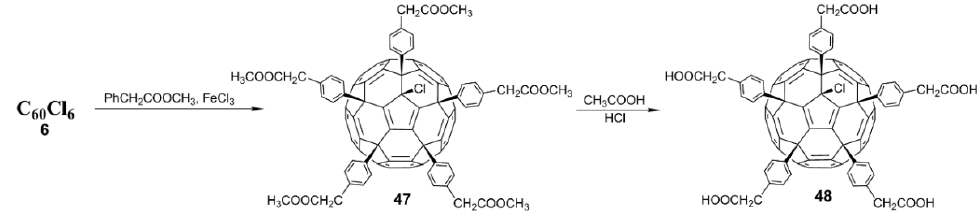
Figure 13. Schematic diagram of synthetic route of carboxylic fullerene derivative ( 48 ).